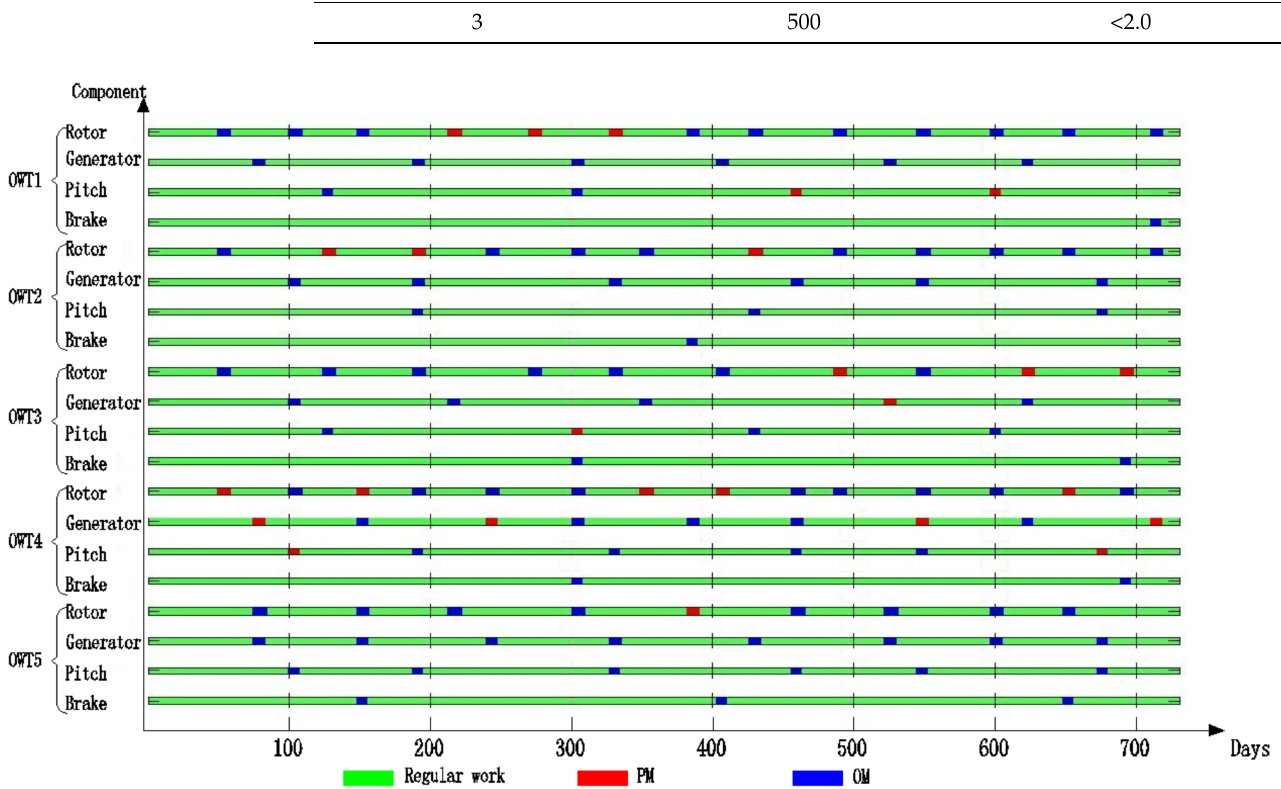
Figure 11. Opportunity group maintenance plan for 4 main equipment of 5